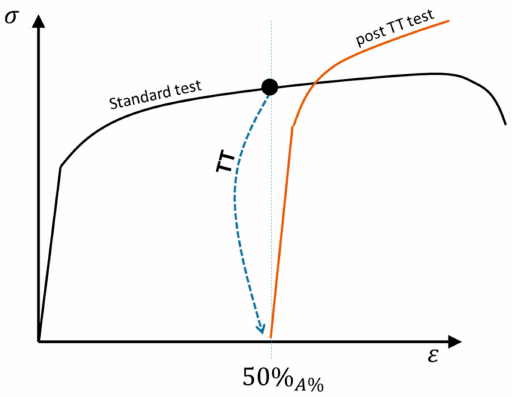
Figure 1. Di ff erence between the as-received (AR) state and post-stretching thermal treatment (PSTT) state shown as a post-TT test.